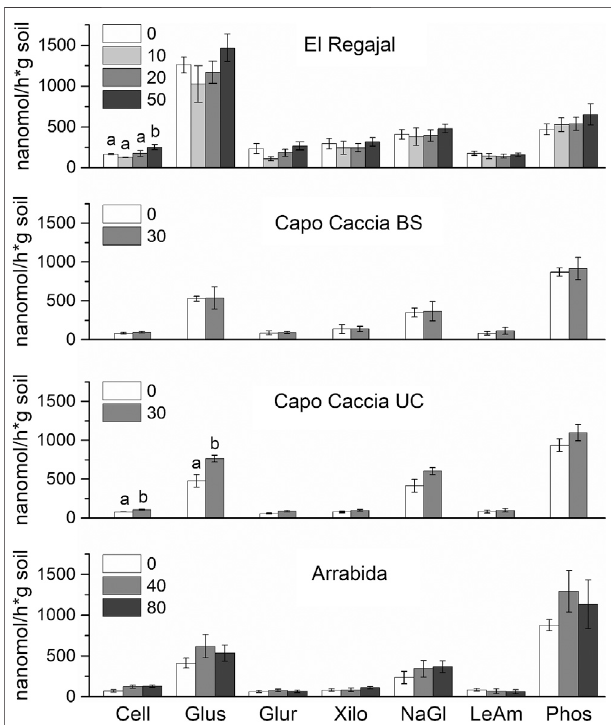
FIGURE 3 | Soil extracellular enzymatic activity (EEA, means ± SE) for each N treatment in El Regajal (Spain, n (cid:2) 6), Capo Caccia BS (Italy, n (cid:2) 4), Capo Caccia UC (Italy, n (cid:2) 4) and Arrábida (Portugal, n (cid:2) 3). Capo Caccia BS and UC indicate bare soil and under canopy microsites, respectively. Letters indicate signi fi cant differences among N treatments within each site ( p < 0.05, one-way ANOVA, post hoc LSD test). Soil EEA showed are respectively:cellobiohydrolase(Cell),glucosidase (Glus),glucoronidase(Glur), xilosidase (Xilo), N-acetyl glucosaminidase (NaGl), Leucine Aminopeptidase (LeAm), phosphatase (Phos).